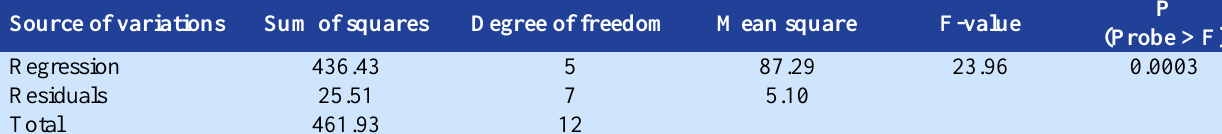
Table 3. Analysis of variance (ANOVA) for the photocatalytic methylene blue (MB) removal